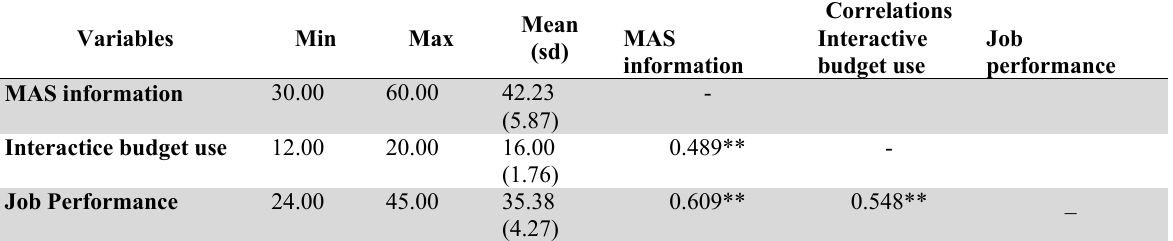
Correlations Mean MAS Interactive Job (sd) information budget use performance